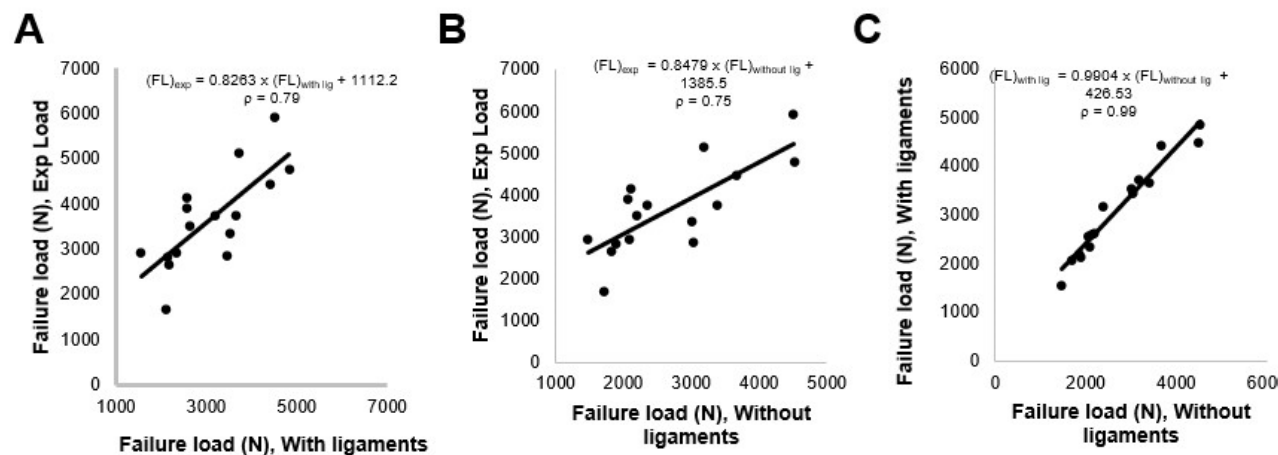
Figure 5. The Correlation plots: ( A ) between the experimental loads and FE failure loads for FSU with ligaments models; ( B ) between the experimental loads and FE failure loads for FSU without ligaments models; ( C ) between the FE failure loads for FSU with ligaments models and FSU without ligaments models.